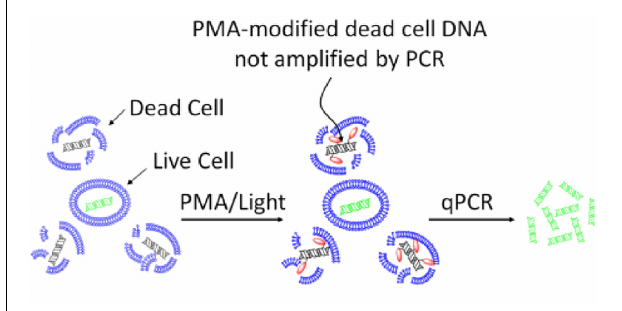
FIGURE 1 | Principle of selective detection of viable cells using PMA dye (https://biotium.com/product/pmatm-dye-20mm-in-h2o/).